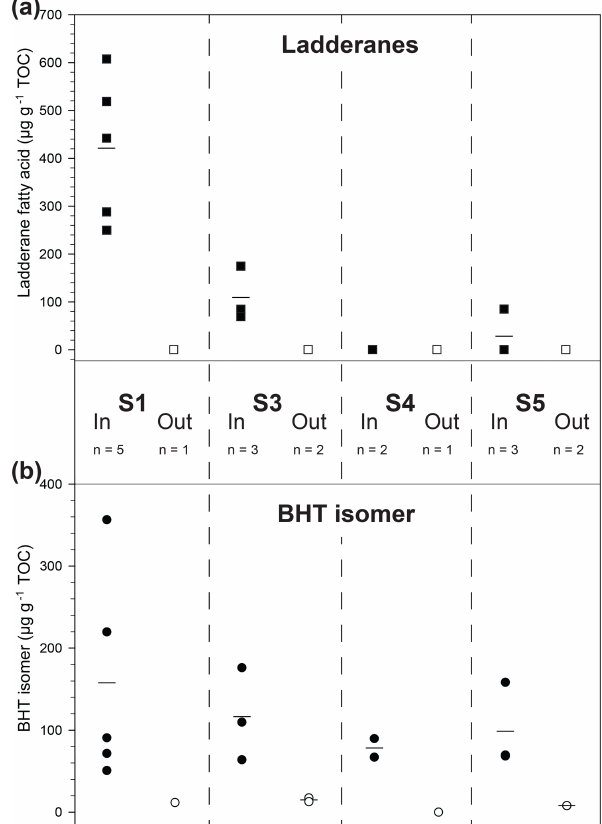
Figure 3. Scattered distribution of (a) ladderane fatty acid concen- tration (squares) and (b) BHT isomer concentration (circles) in four recent sapropels (S1–S5; 7–125ka) from the Aegean Sea (R/V Mar- ion Dufresne LC21 ). Filled symbols denote samples taken within a sapropel sediment and open symbols from outside. Lines are the mean markers when data points are not